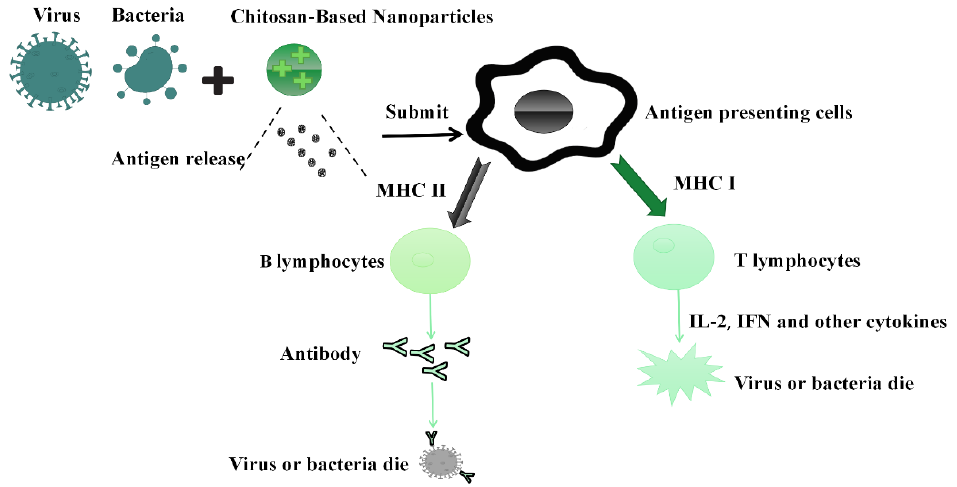
Figure 2. Immune mechanism of chitosan against viruses and